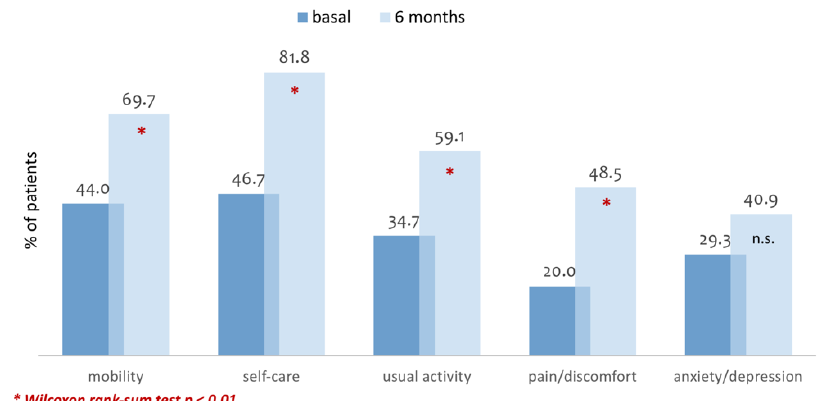
Figure 1. Percentage of patients that express not having any health problems (EQ5D5L).